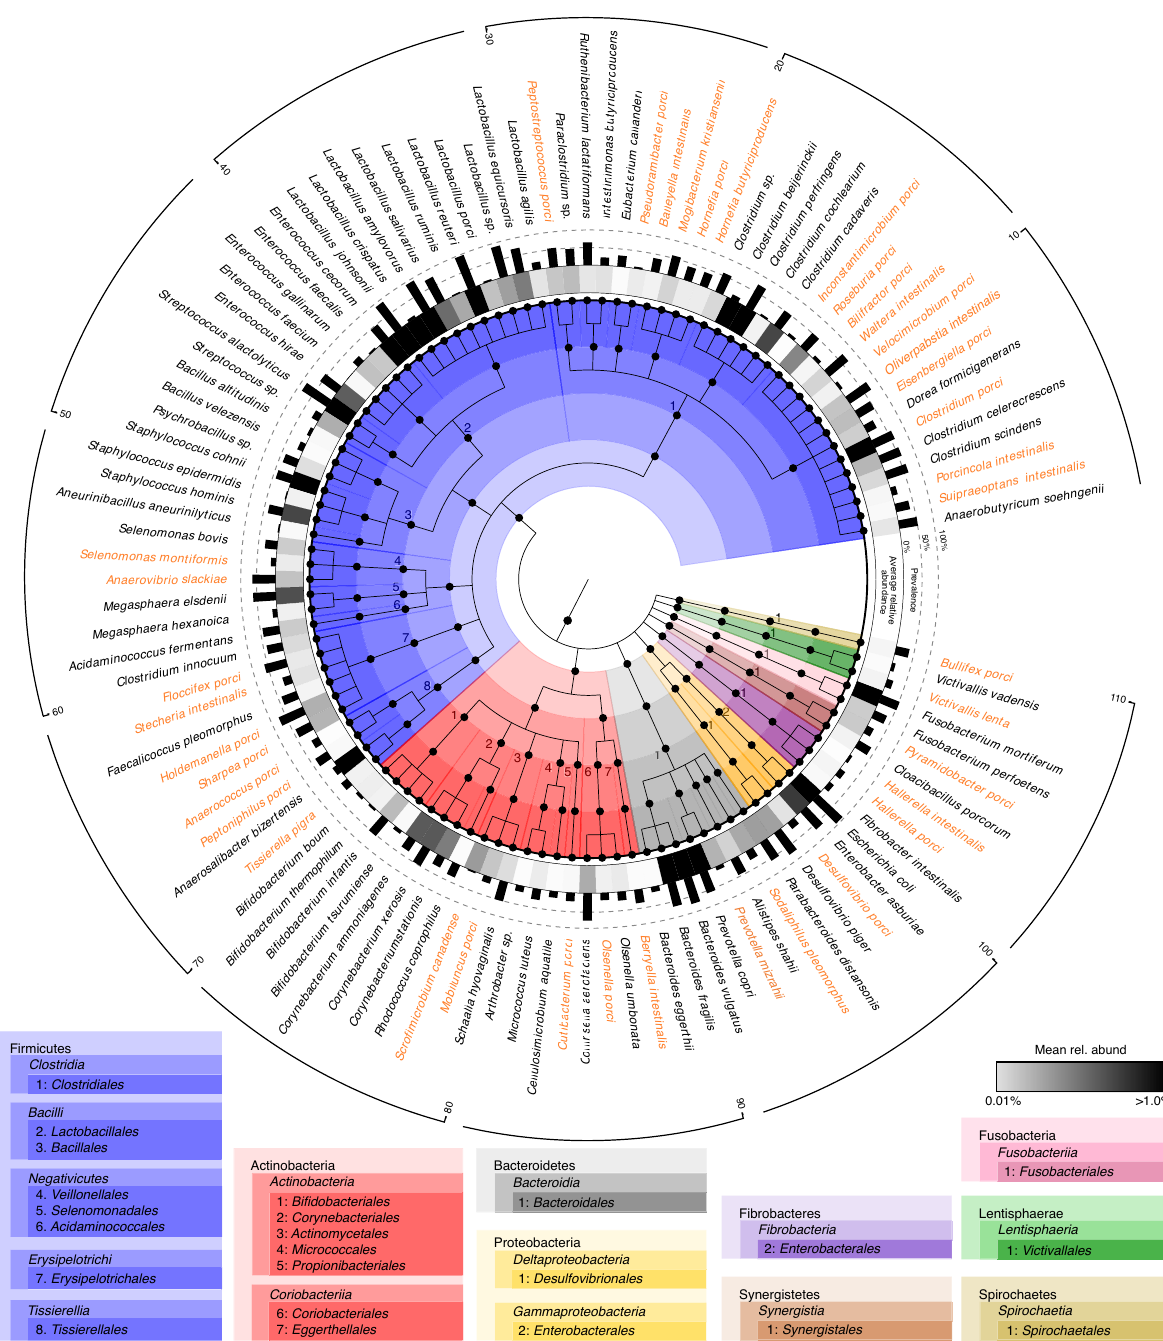
Fig. 1 Species within the pig intestinal bacterial collection (PiBAC). Cladogram depicting the taxonomic classi fi cation of all 110 species. The colour code is according to phyla and the lineage of bacteria is given in boxes below the cladogram. Novel taxa (their candidate names) appear in orange letters. The outer black bars represent the prevalence of each species as determined by 16S rRNA gene search against 1346 pig gut-derived amplicon datasets (see Methods). The grey gradient below indicates the mean relative abundances of each isolate in the samples that were positive for the given present within all studied genomes, homologous genes to the (Fig. 2c) 34 . Interestingly, only B. porci and Sphaerochaeta penicillin-binding proteins 1a, 2, and C were absent from coccoides lacked the mreB gene involved in cytoskeleton ring Sphaerochaeta spp. and B. porci (Fig. 2c). Analysis of peptidogly- formation leading to cell rigidity 35 . Among the conserved proteins forming the divisome (or septal ring) involved in cans detected the presence of murotetrapeptides containing L- bacterial binary fi ssion 30 , ftsQ and ftsX were absent in B. porci Orn at third position of the peptide chain linked to a glycine (Fig. 2c and Supplementary Fig. 2a). Both genes were reported to (Supplementary Fig. 11). Altogether, these investigations high- be also absent within the genomes of Planctomycetes species with light the particular cell structure of B. porci . Further studies are unusual modes of cell division 32 . Regarding peptidoglycan needed to dissect the cellular biology of this novel species (e.g. its biosynthesis, whilst the murA-G , murJ , and mraY genes were mechanisms of cell division).